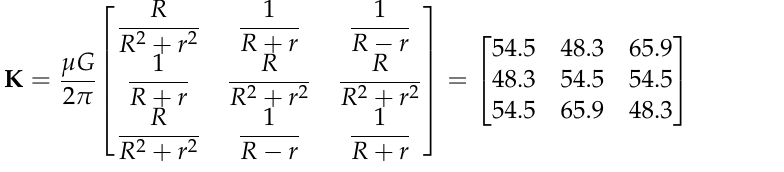
Figure 6. Physical view of the fluxgate sensor array. The fluxgate sensor array is drawn as a two-layer PCB with three sensors sensitive axis to the center of the array 17.5 mm, chip DRV425RTJT, and calculated sensor measurement gain G = 4.88 V/mT. According to Equation (2), in Figure 5 the position relationship can be derived from the matrix K, as shown in Equation (4), unit